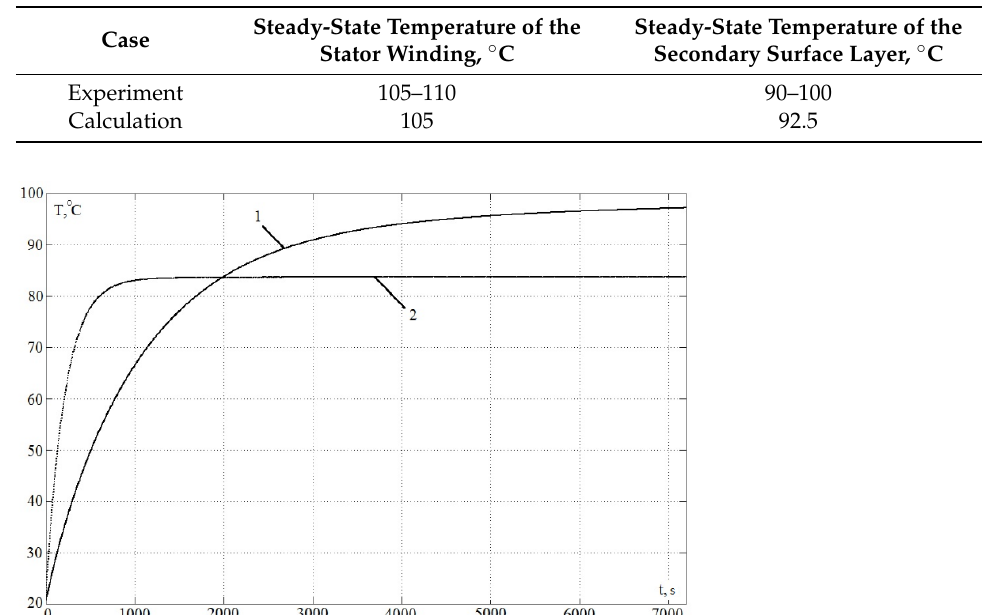
Table 9. Comparison of experimental and calculated temperatures arc IM for rated operation with direct start-up.